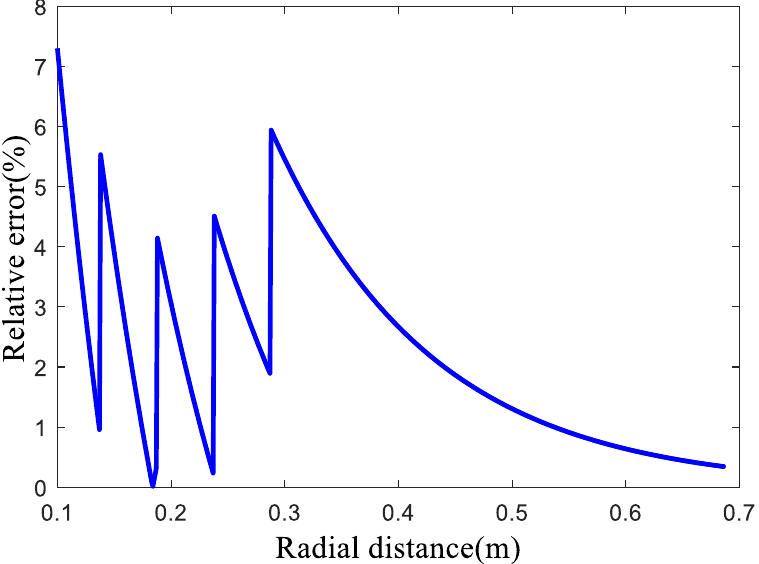
Figure 6. Radial distribution of relative error between inversion result and real formation velocity. From Figure 6, due to the high-frequency constraints, the inversion method had a relatively high accuracy, and the overall error was basically below 4%, and especially in the near-borehole formation a high inversion-accuracy could be